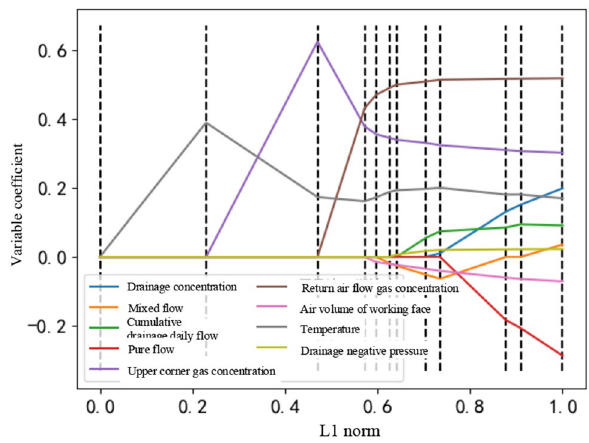
Figure 8. Variable coefficients based on lasso feature selection.